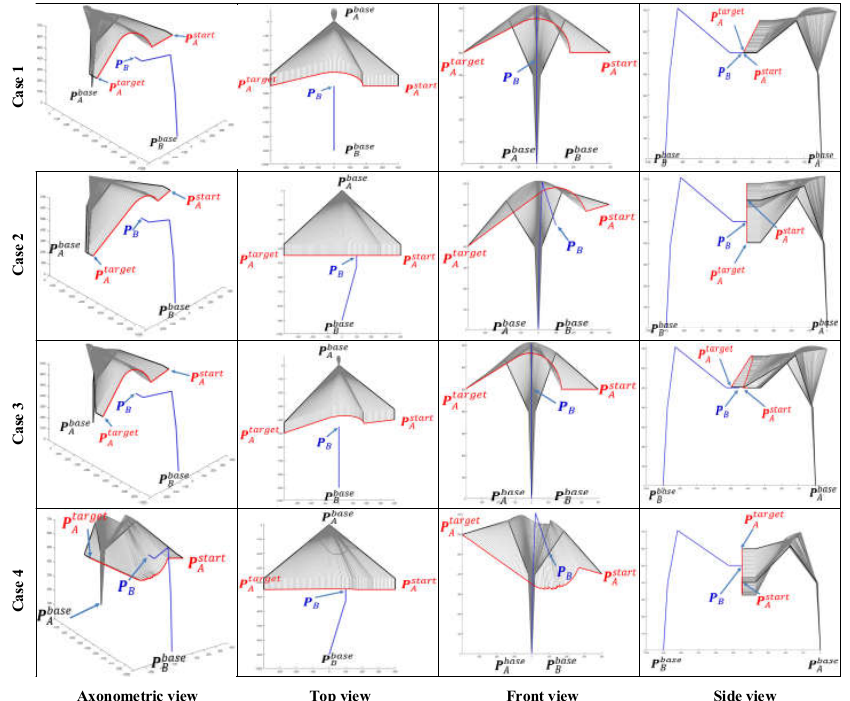
Figure 7. Comparison of single manipulator avoidance simulation results for four initial path cases.